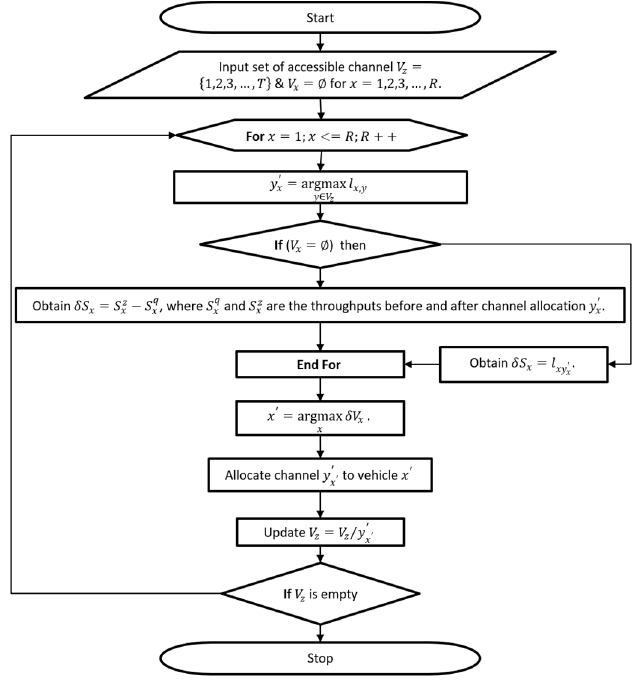
Figure 3. Flow diagram of proposed non-shared channel allocation.